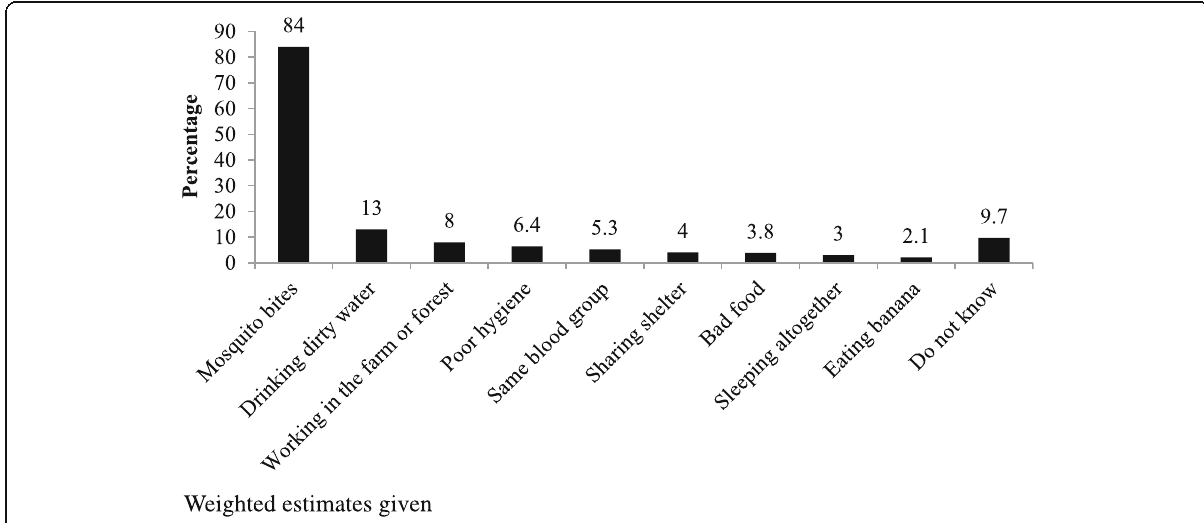
Fig. 2 Awareness about cause and transmission of malaria among the general population in the endemic regions of Myanmar in